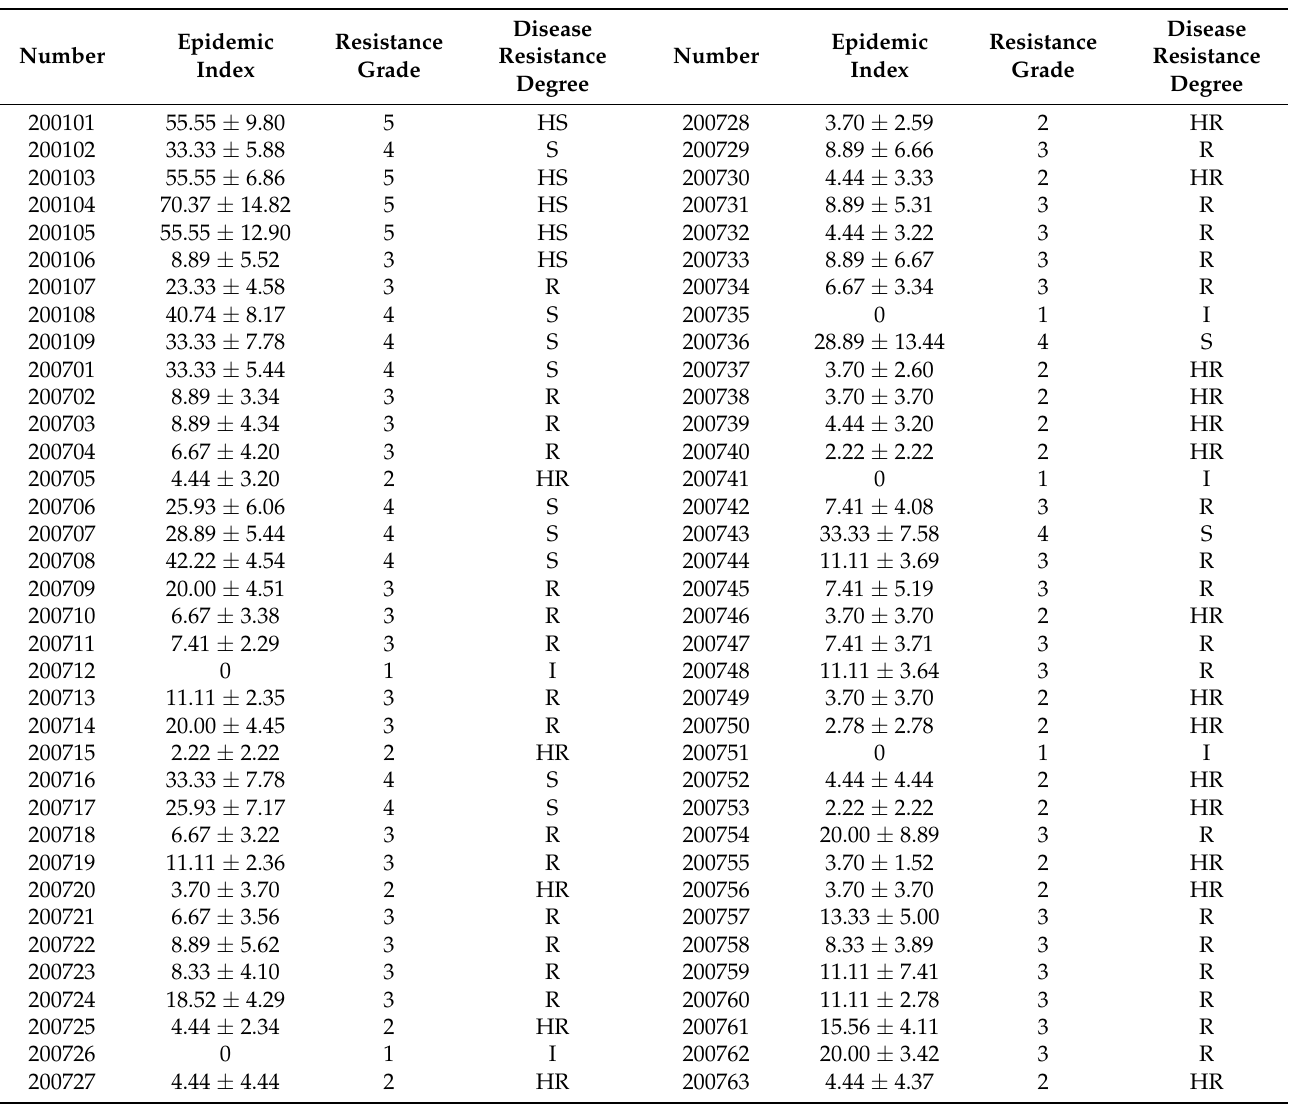
Table 3. Disease resistance of F 1 population of